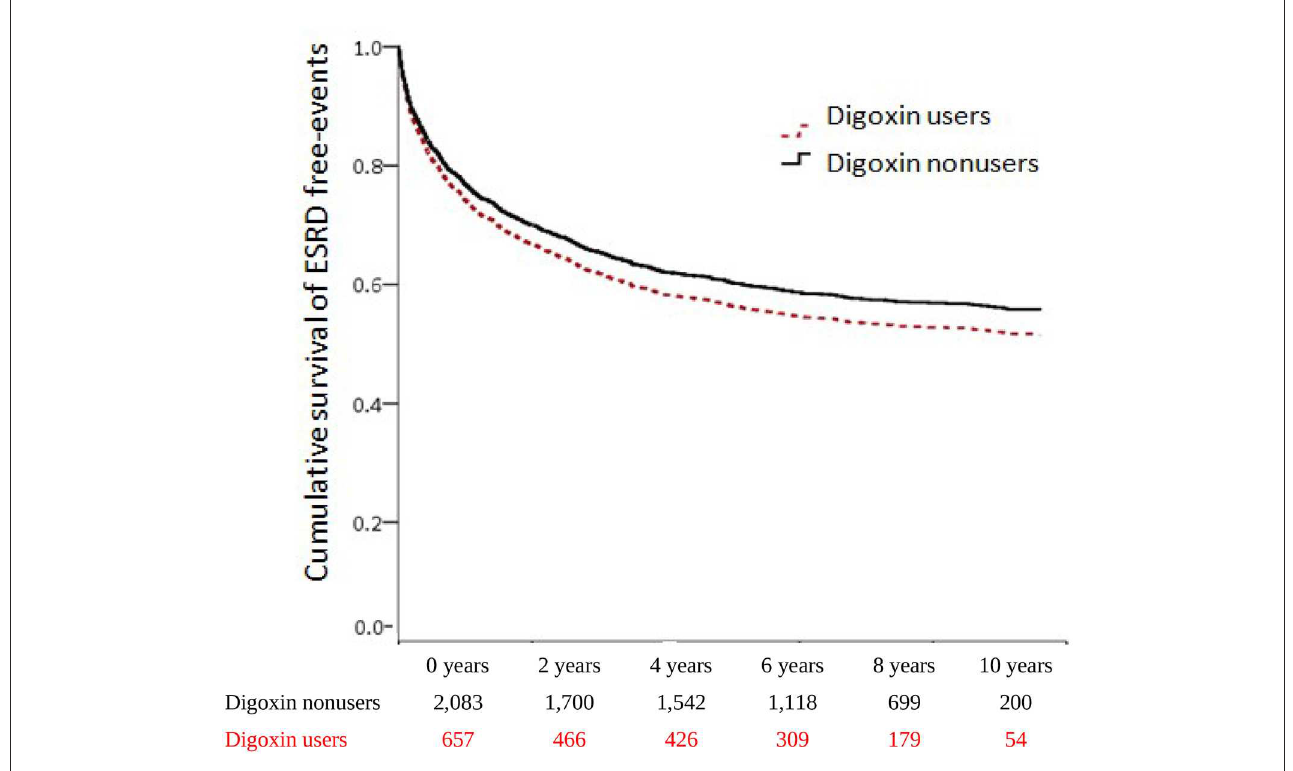
FIGURE4 Cumulative hazards of ESRD among patients with CRS.